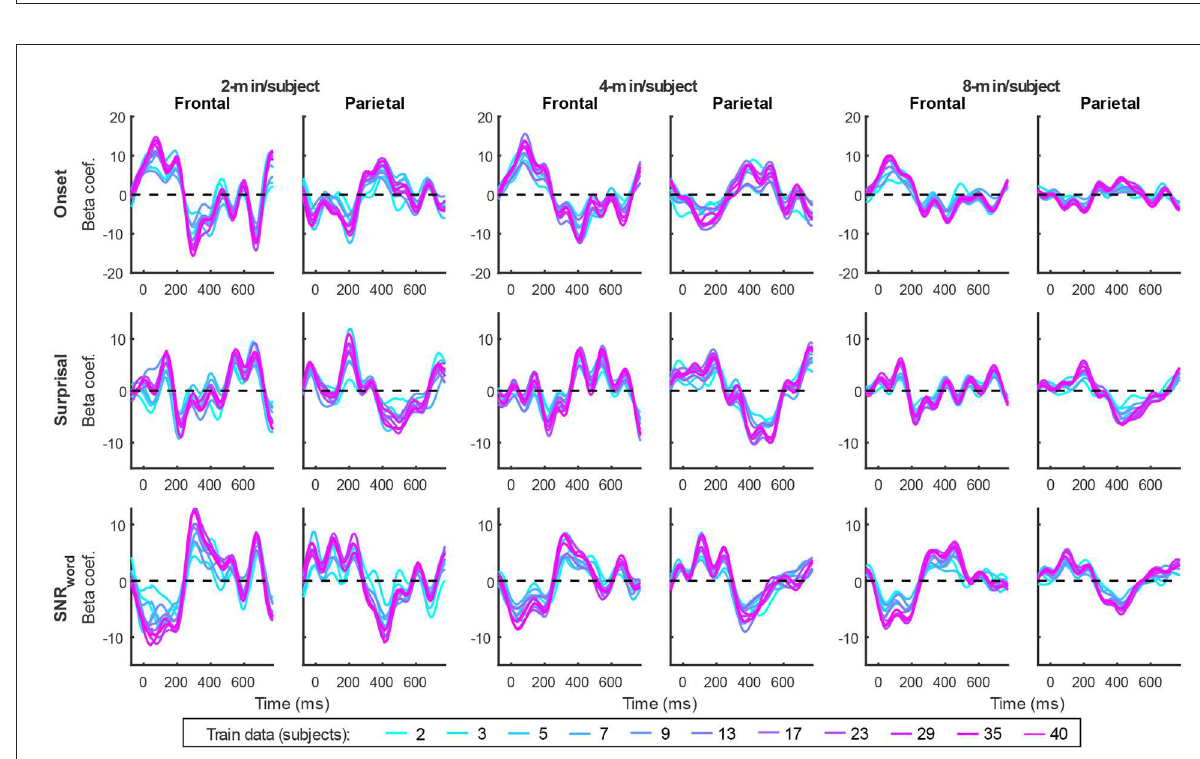
FIGURE13 Average generic model TRF time courses for onset (top row) , surprisal (middle row) , and SNR word (bottom row) features from the sparser model trained with 2-min ( left pair of columns), 4-min ( middle pair of columns), and 8-min ( right pair of columns) of data per subject. TRFs estimated using different amounts of data are depicted in different colors (see legend at the bottom of the